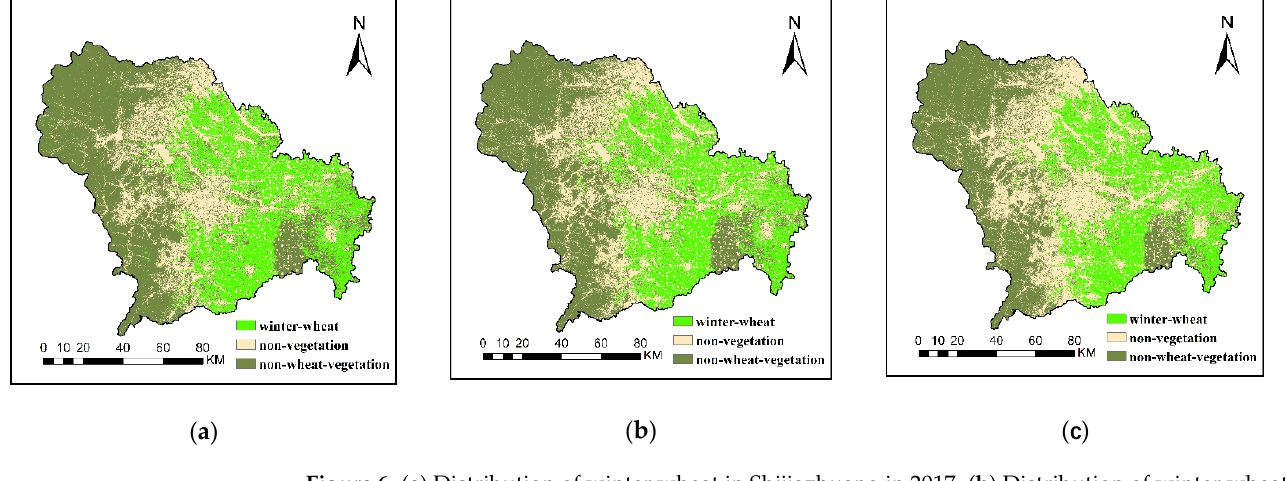
Figure 6. ( a ) Distribution of winter wheat in Shijiazhuang in 2017. ( b ) Distribution of winter wheat in Shijiazhuang in 2018. ( c ) Distribution of winter wheat in Shijiazhuang in 2019.